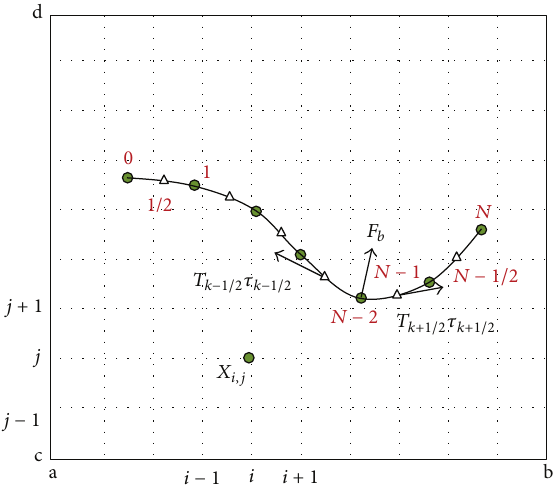
Figure 1: Schematic representation of the Lagrangian coordinate system for a flexible filament located in the Eulerian